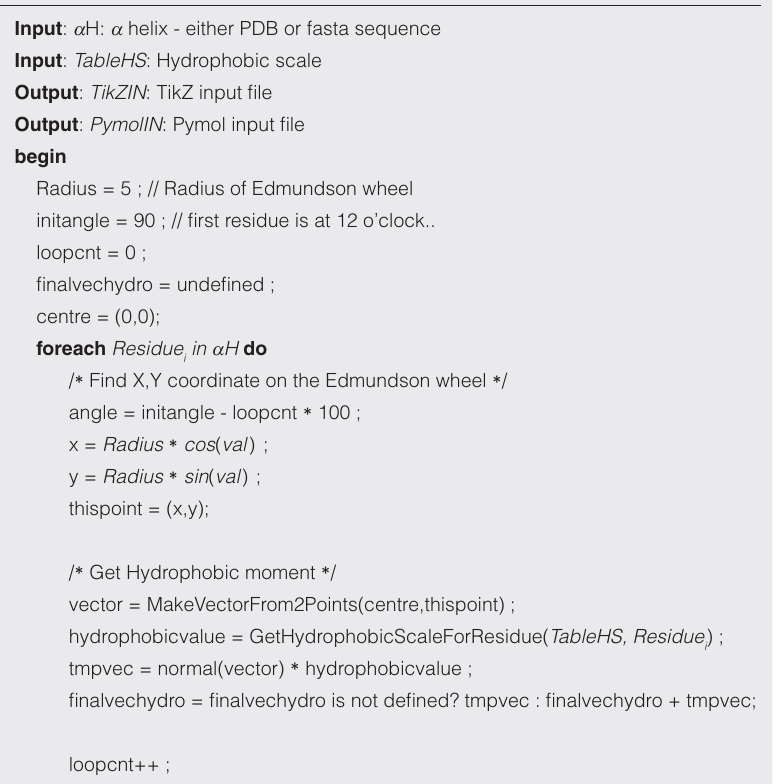
Algorithm 1. Calculate hydrophobic moment